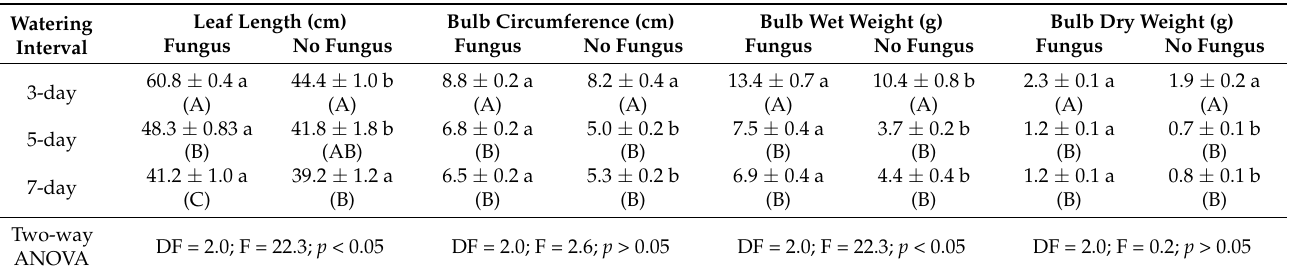
Table 1. Effects of the watering regime and endophytic B. bassiana on plant growth parameters (mean ± SE) of A. cepa